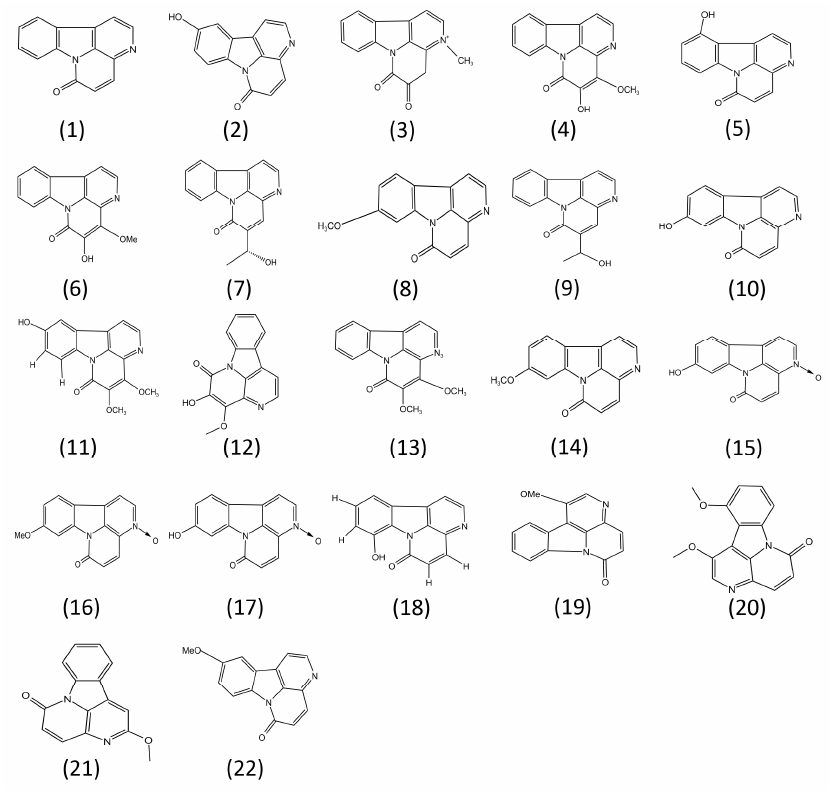
Figure 1. Chemical structures of canthin-6-one and its derivatives. Compound numbers correspond to the compound names in Table 1 and Table 2.